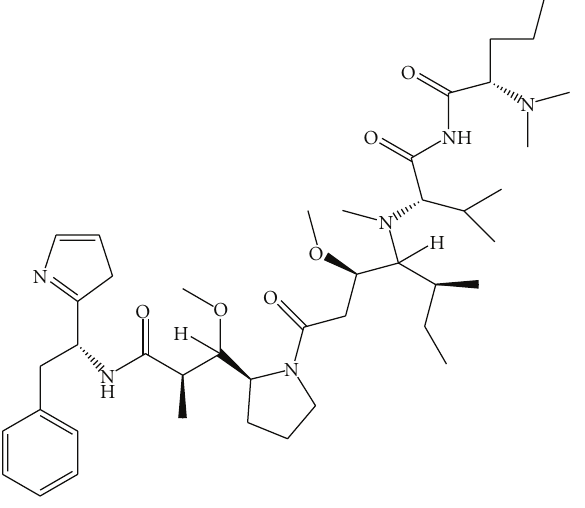
Figure 9: Structure of symplostatin